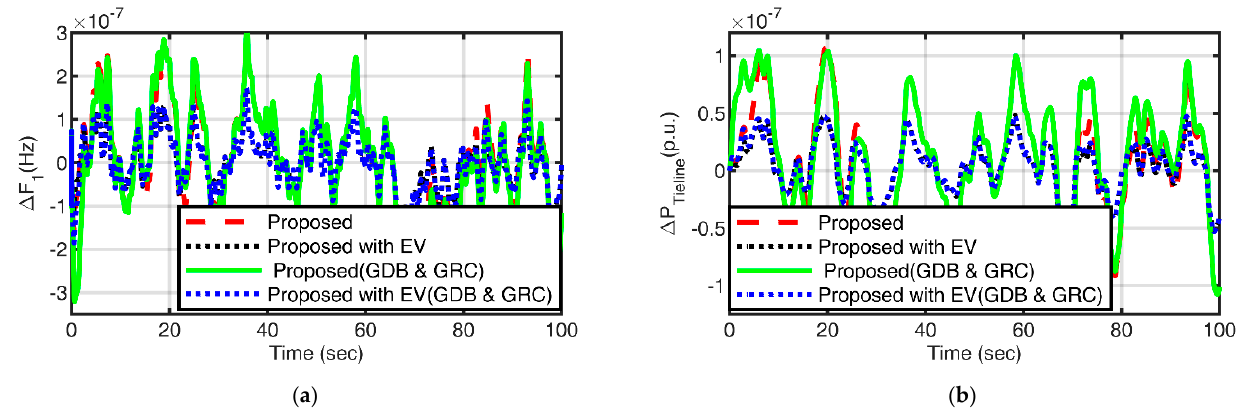
Figure 13. ( a ) Frequency response of area 1 with non-linearity. ( b ) Tie-line power response with non-linearity.